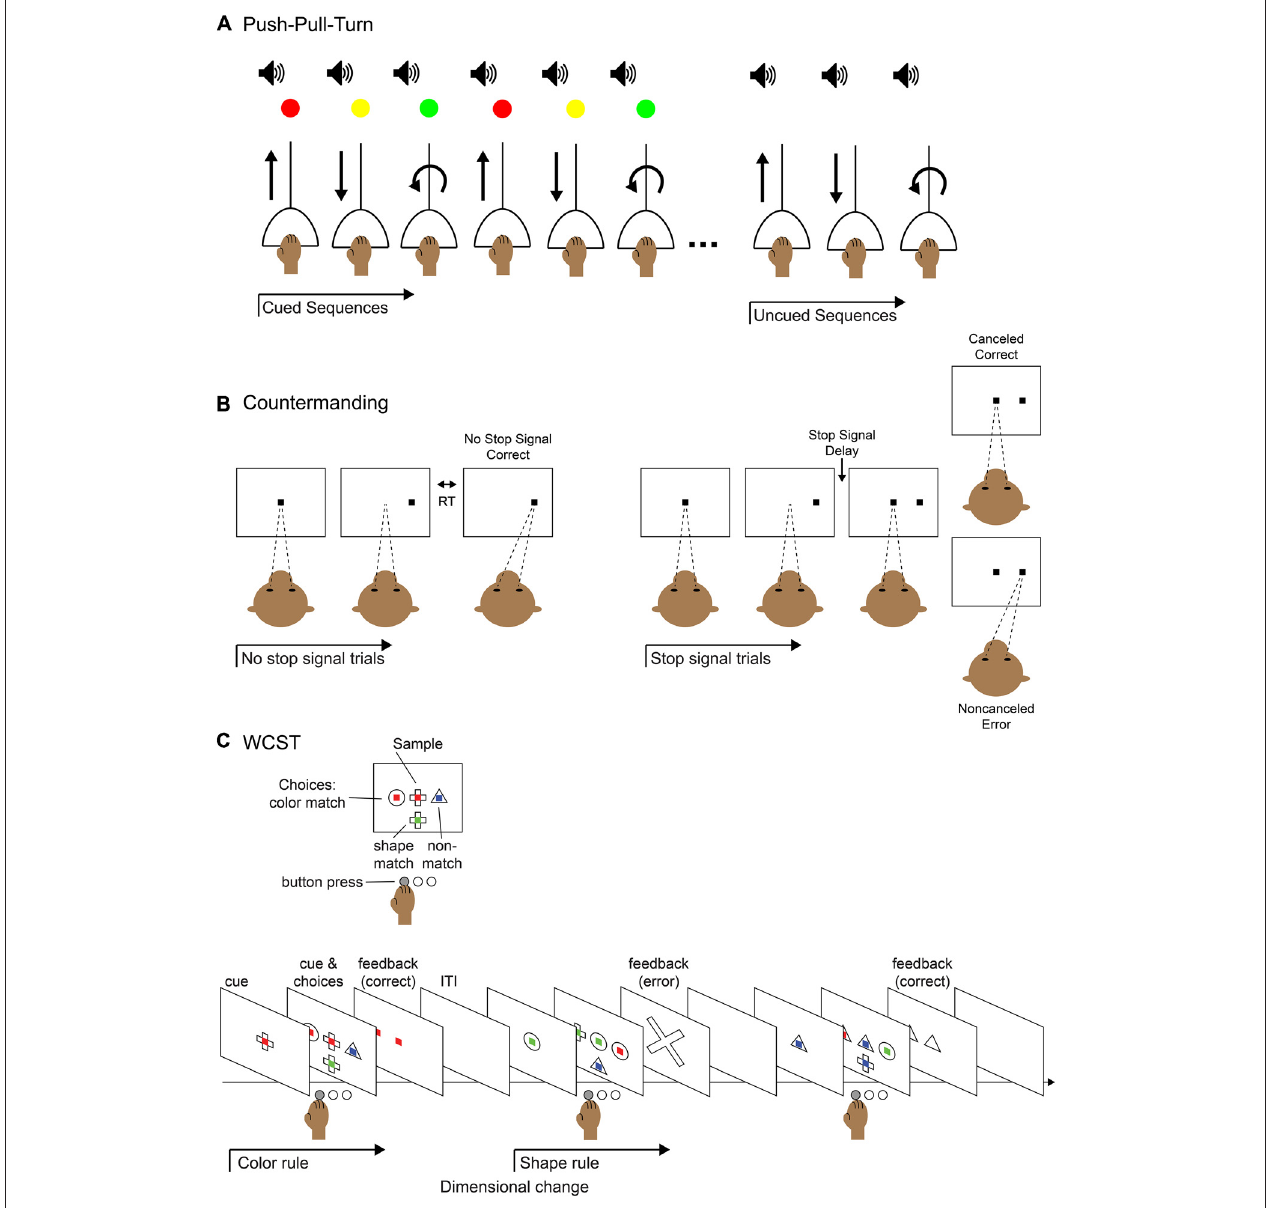
FIGURE 2 | Behavioral tasks for studying elements of control. (A) Push-pull-turn task. The subject is instructed to complete a series of movements with an audio cue for movement timing and a light cue that indicates which movement to perform. After a few blocks of trials, the light cue is removed and the subject continues performing the remembered sequence of movements. (B) Saccade countermanding task (a.k.a. stop-signal task). The subject is instructed to hold fixation on a central fixation point until it is extinguished and make a saccade to a target that appears in the periphery; this is called a “no-stop” trial. On a fraction of trials, after the initial fixation point is extinguished and before the peripheral target appears, the fixation point reappears in the center. This is the “stop-signal” to abort the saccade and maintain fixation on the central fixation point. On a “stop trial,” maintaining fixation would be correct and executing the saccade to the periphery would be an error. The duration of the time before the fixation point reappears, the stop-signal delay, can be modulated to titrate the difficulty of the task: the longer the delay, the more difficult to it is to abort the saccade. (C) Wisconsin Card Sort Task (WCST). The subject is instructed to select the visual stimulus that matches the sample stimulus based on one of two rules: color match or shape match. The current rule is determined by trial and error and remains in operation until a dimension change. The subject presses a button to select the appropriate stimulus and is given feedback after the response.